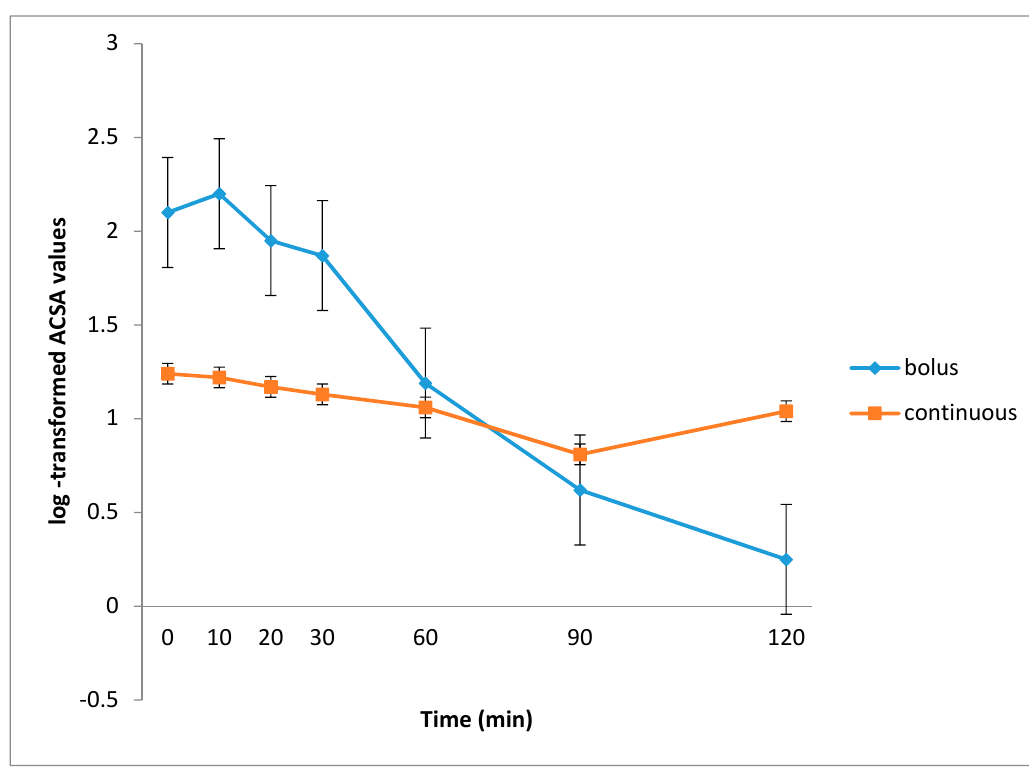
Figure 2. Pattern of gastric antral cross-sectional area (ACSA) values (log-transformed) reduction through different study time points according to feeding method (intermittent vs. continuous). Error bars represent standard error of the mean.